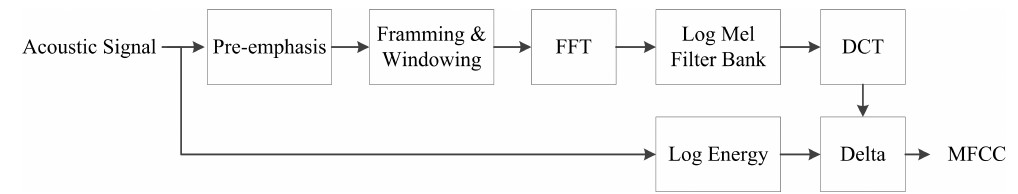
Figure 4. The diagram of MFCC